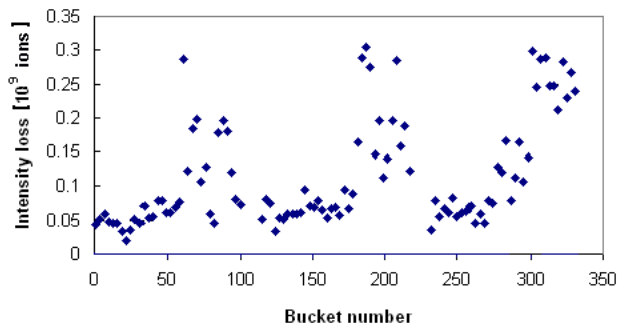
FIG. 13. (Color) Yellow beam loss at transition as a function of position in the bunch train. In this pattern 8 bunches are missing after 1 = 3 and 2 = 3 of the bunch train length. The bunch train is followed by the abort gap. The intensity losses per bunch increase until a gap is reached, and then fall back because the electron cloud decays.